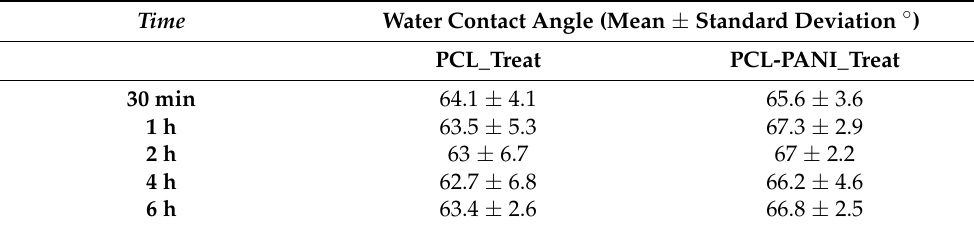
Table 3. Time durability after atmospheric Ar plasma treatment of PCL_treat and PCL-PANI_treat. Time